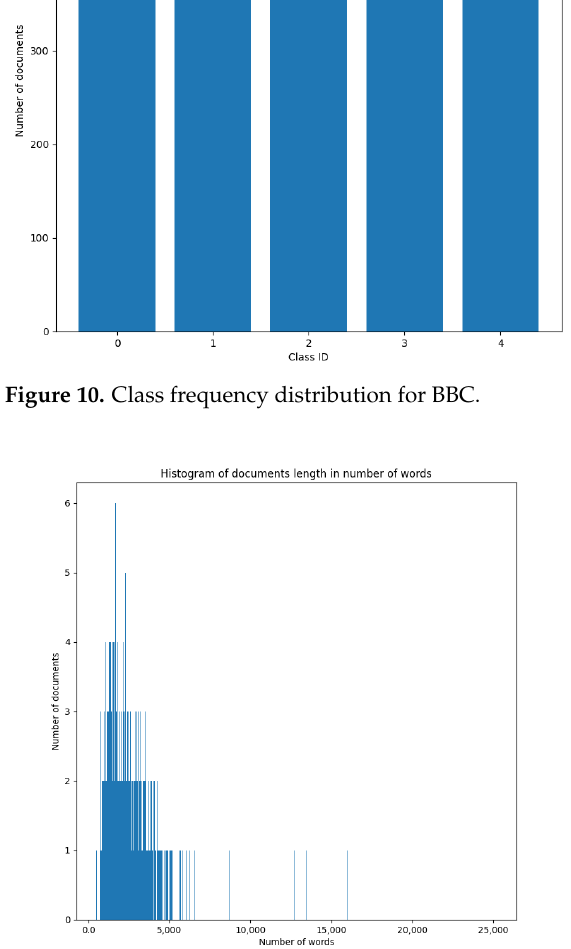
Figure 11. Distribution of words frequency in